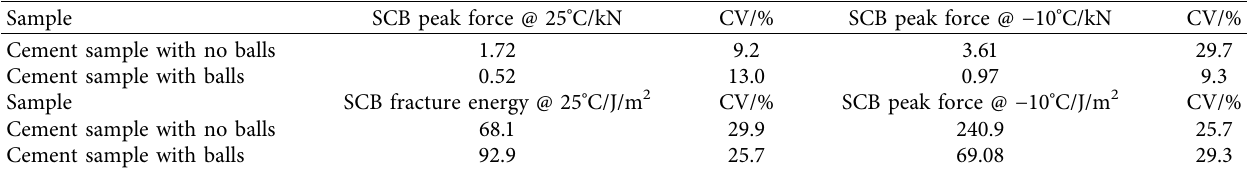
Figure 15: SCB fracture energies of PAM and CCAM samples. (a) 25 ° C. (b) − 10 ° C. Table 6: SCB peak force of cement samples.